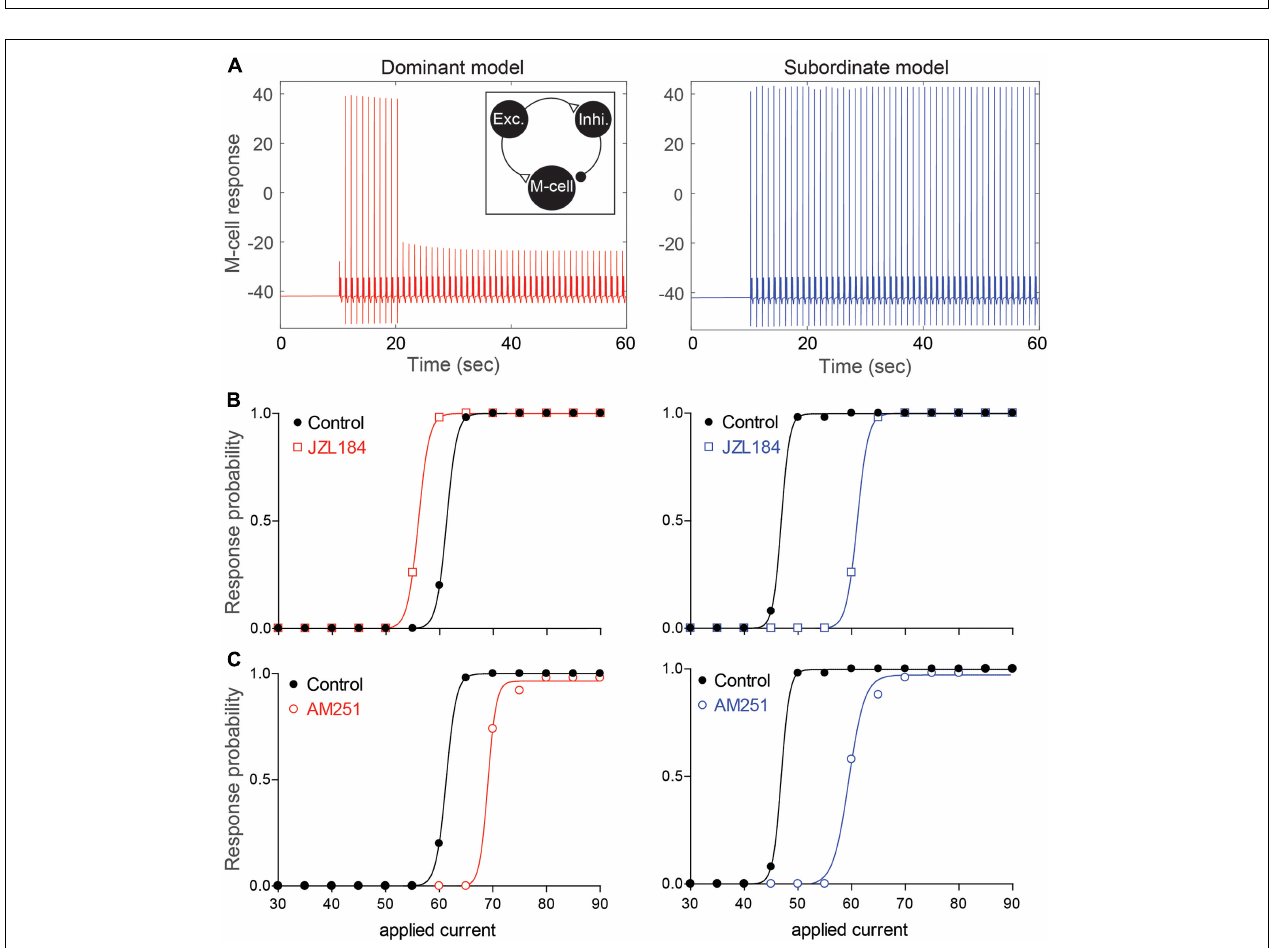
FIGURE 6 | Neurocomputational models simulating the effects of 2-AG on the escape response. (A) Examples of the response of the M-cell model cell within a simple model network (inset) to repeated suprathreshold applied current injection in dominant-like (left) and subordinate-like (right) models. (B,C) Results of dominant-like and subordinate-like models simulating the probability of startle escape response before (control, black solid line) and during [JZL184, (B) ] and blockage of CB 1 R [AM-251, (C)